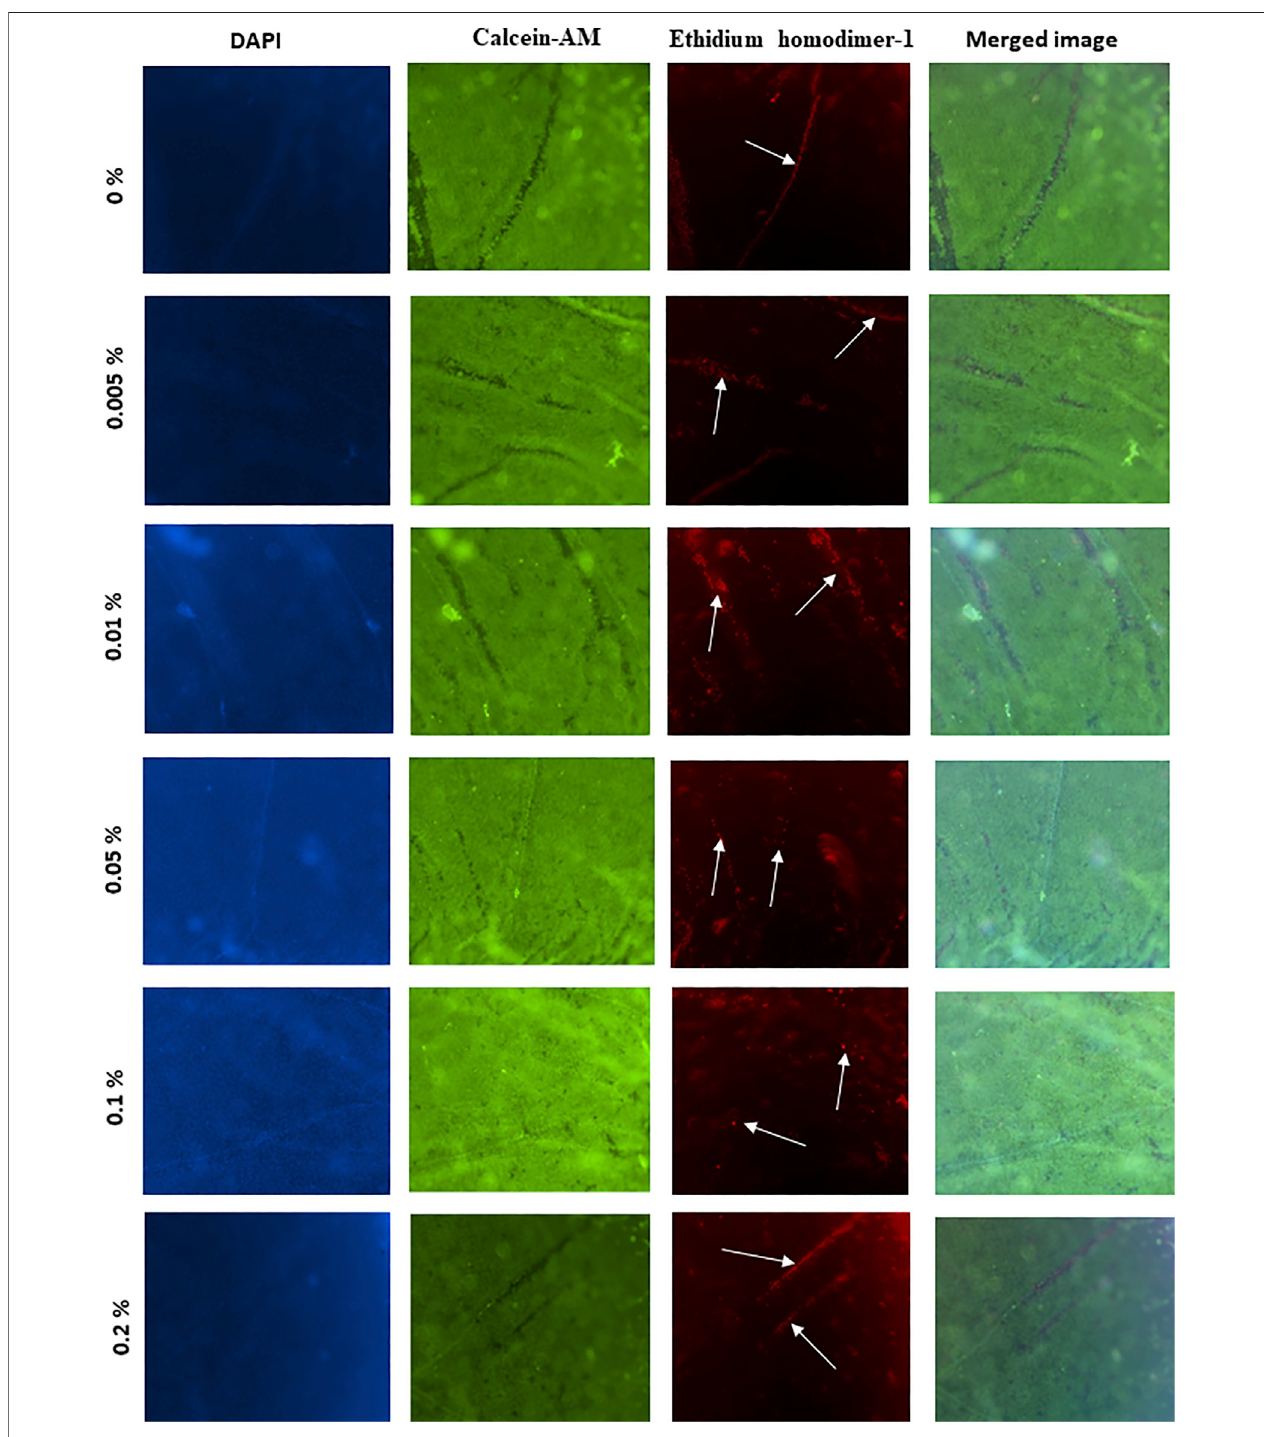
FIGURE3| Theeffectoftacrolimuson epithelialcell viability. Concentrationsoftacrolimussolutionsused totreat each groupofcorneas areshown on theleft. The fi rstpanelshowsDAPIstaining.Viablecellsarestainedgreen(secondpanel),whiledeadcellsarestainedred(thirdpanel).Thefourthpanelshowsamergedimageofthe images in the same row. Each image is a representative of three replicates ( n = 3). All images were captured using ×10 magni fi cation using a laser scanning confocal microscope.